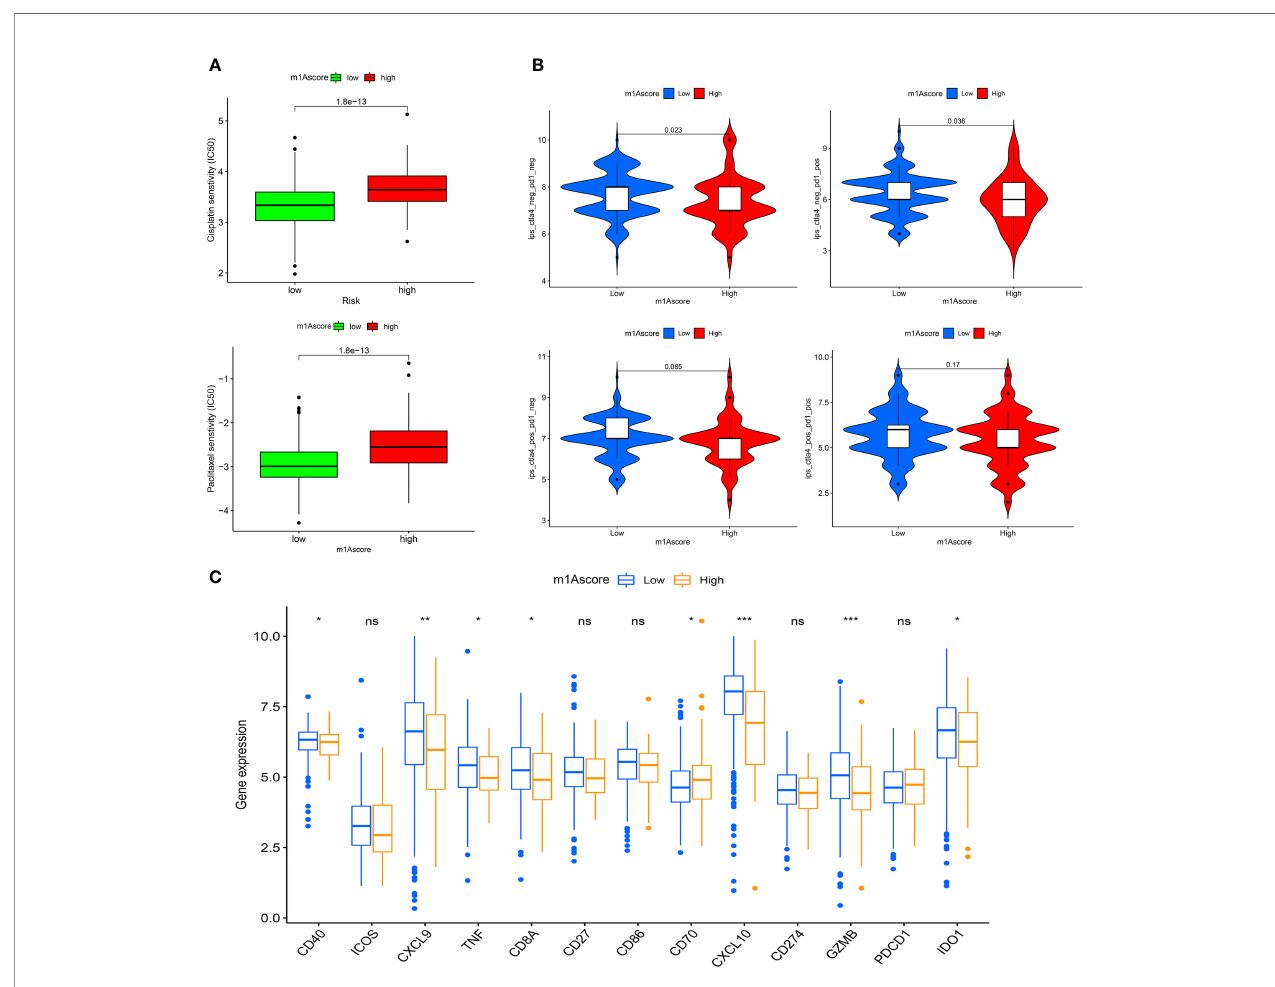
FIGURE 8 | m1A modi fi cation patterns in the role of OC clinical therapies (A) Box plot showing the sensitivity of patients with high and low m1Ascore subgroups to chemotherapy drugs, including cisplatin and paclitaxel. (B) The association between IPS and immune checkpoints in OC patients with different m1Asocre. (C) The expression of immune-relevant genes in high and low m1Ascore subgroups. *P < 0.05; **P < 0.01; ***P < 0.001; ns, not signi fi cant.